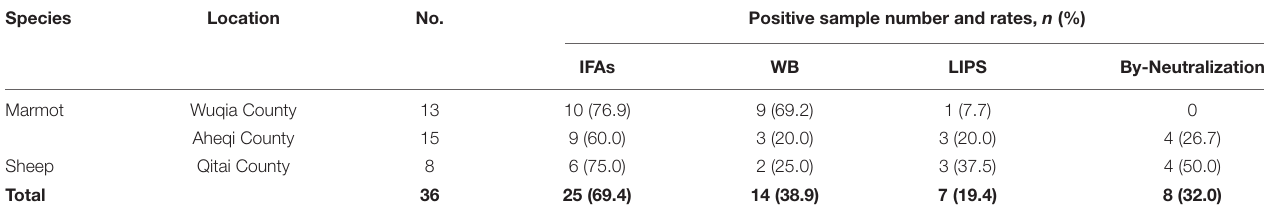
TABLE 3 | Antibody response against tick-borne encephalitis virus among Karshi virus-IFA positive animal serum samples. Species Location No. Positive sample number and rates, n (%) IFAs WB LIPS By-Neutralization Marmot